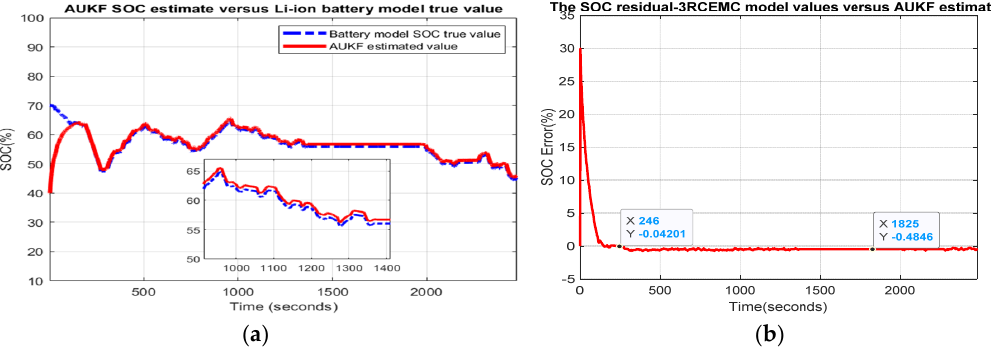
Figure A20. Robustness to simultaneous changes, SOCini = 0.4, σ noise = 0.01; ( a ) AUKF SOC value versus battery model true value; ( b ) SOC residual.